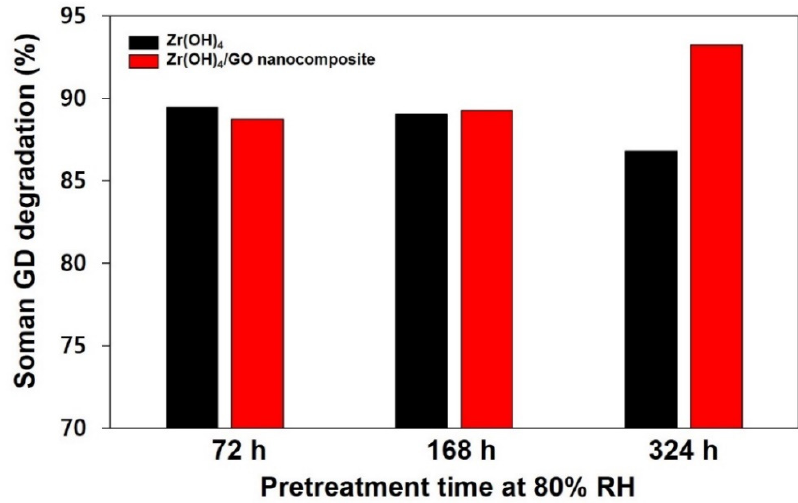
Figure 4. Degradation of nerve agent soman (GD) by and Zr(OH) 4 / GO nanocomposite and pristine Zr(OH) 4 . The samples were pretreated for various times (72, 168, 324 h) at 80% RH in a 25 °C convection oven.